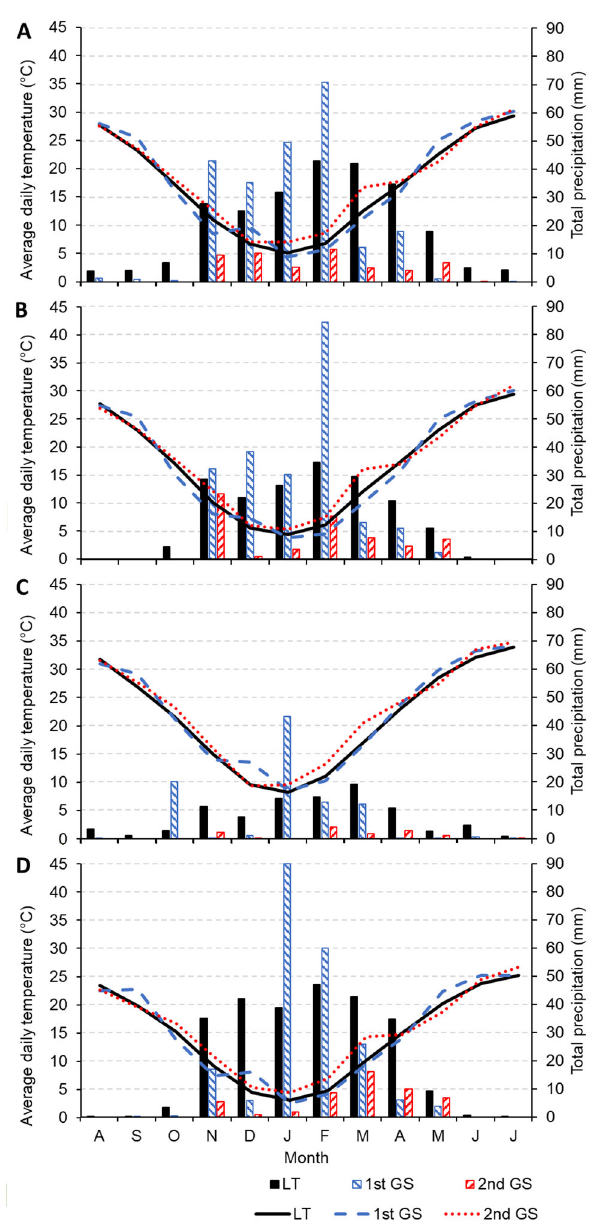
Figure 2. Walter-Lieth diagram of the study sites. ( A ) BGL (Baghlan), ( B ) BLK (Balkh), ( C ) HLM (Helmand) and ( D ) HRT (Herat). The long-term (LT) (2001–2020), average monthly temperature ( ◦ C, black continuous line) and monthly average precipitation (mm, black histograms). The 1st growing season (1st GS), (2016/2017), average monthly temperature ( ◦ C, blue dashed line) and monthly average precipitation (mm, blue histograms). The 2nd growing season (2nd GS), (2017/2018), average monthly temperature ( ◦ C, red dashed line) and monthly average precipitation (mm, red histograms).